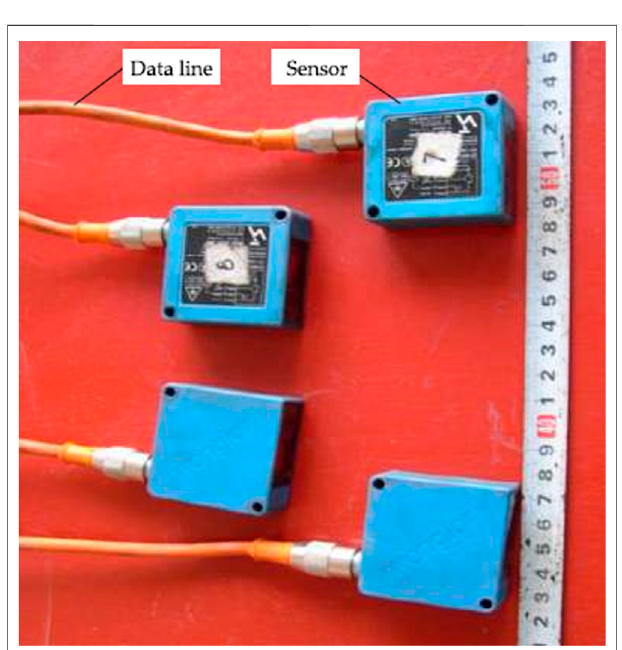
FIGURE9| High-precisionlaserdisplacementsensorsusedtomeasure the top of the embankment deformation.